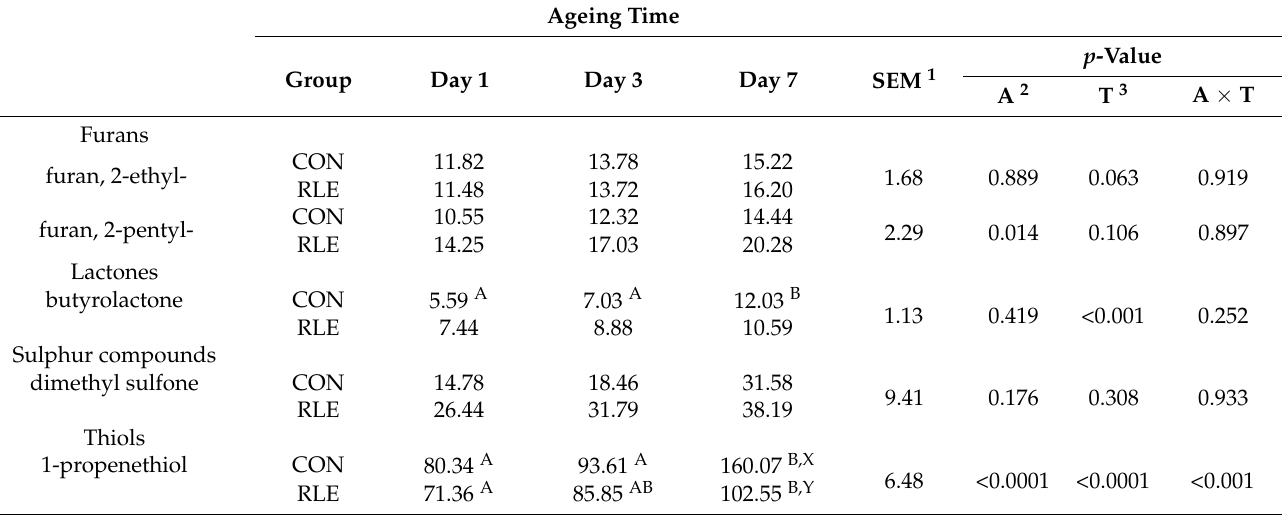
Table 7. Effects of anthocyanin diet addition and ageing on furans, lactones, sulphur compounds and thiols of meat from goat kids ( n = 30 samples for each experimental group). Results are expressed as ng/g of